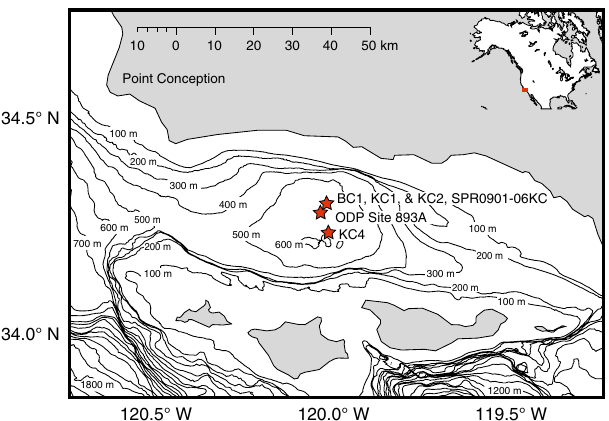
Fig. 1 Map of Santa Barbara Basin showing locations of sediment cores. BC1, KC1, and KC2 in this study were taken at station MV1012-ST46.9 (34° 17.228 ′ N, 120° 02.135 ′ W). KC4 was taken at station MV1012-ST46.2 (34° 13.700 ′ N, 120° 01.898 ′ W). Cores from SPR0901 – 06KC (34° 16.914 ′ N, 120° 02.419 ′ W) and ODP Site 89 A (34° 17.25 ′ N, 120° 02.2 ′ W)